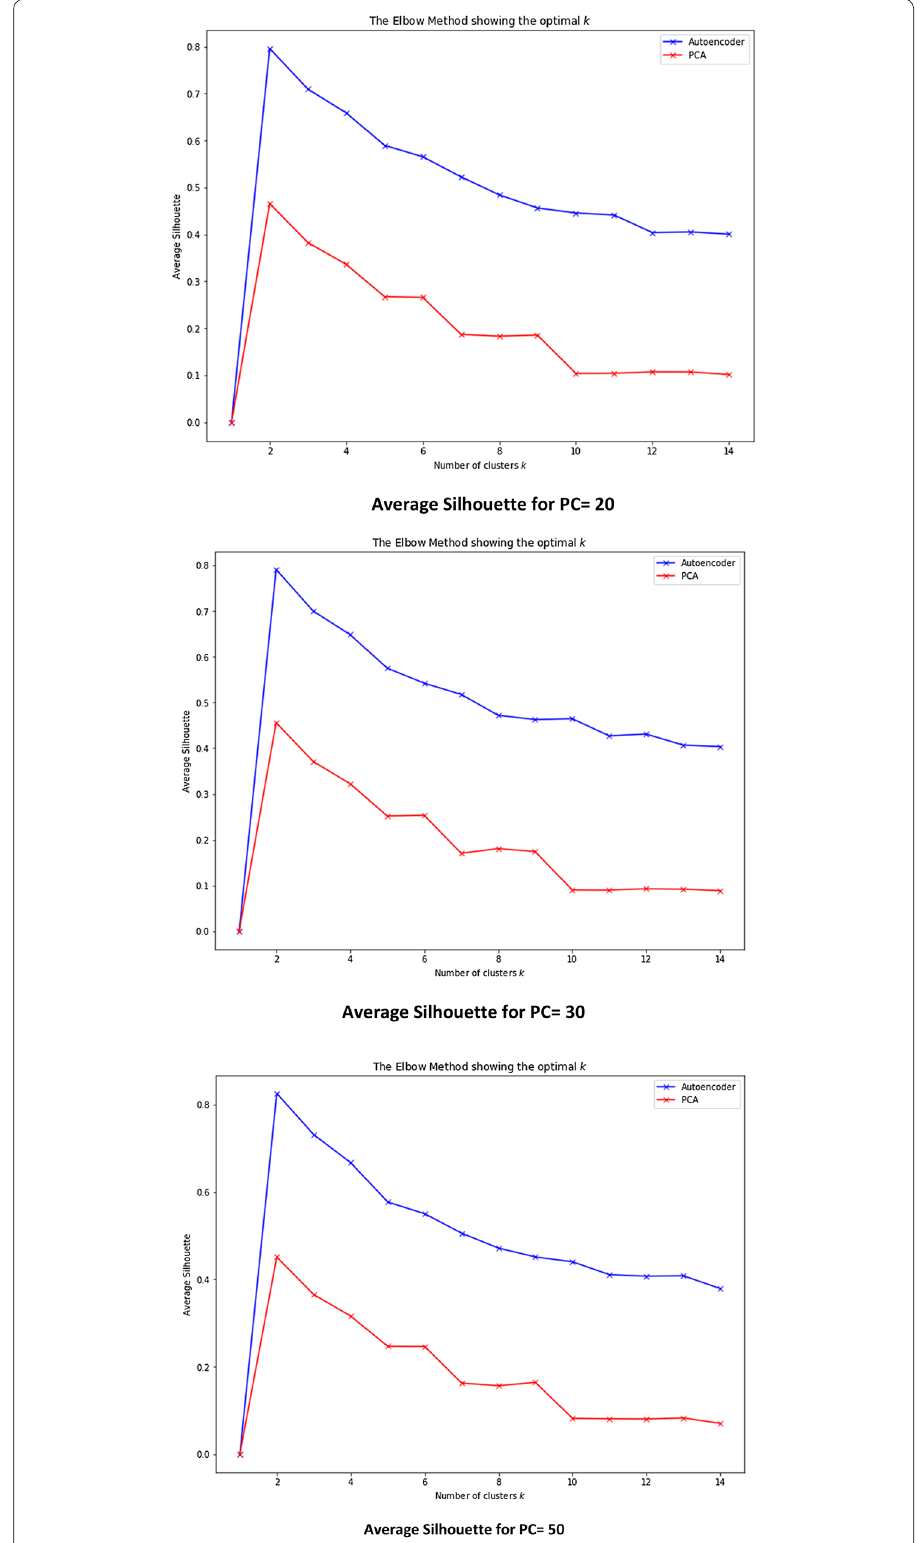
Fig. 8 Average Silhouette score with different